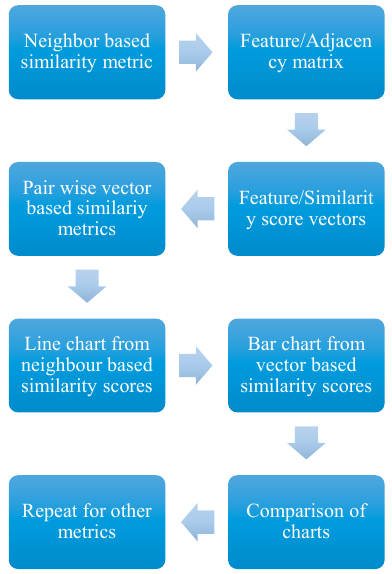
Figure 4. High level view of the proposed model.